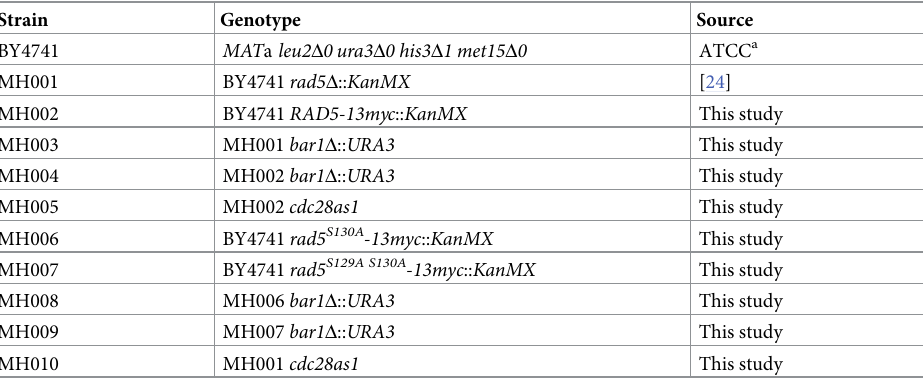
Table 1. S . cerevisiae strains used in this